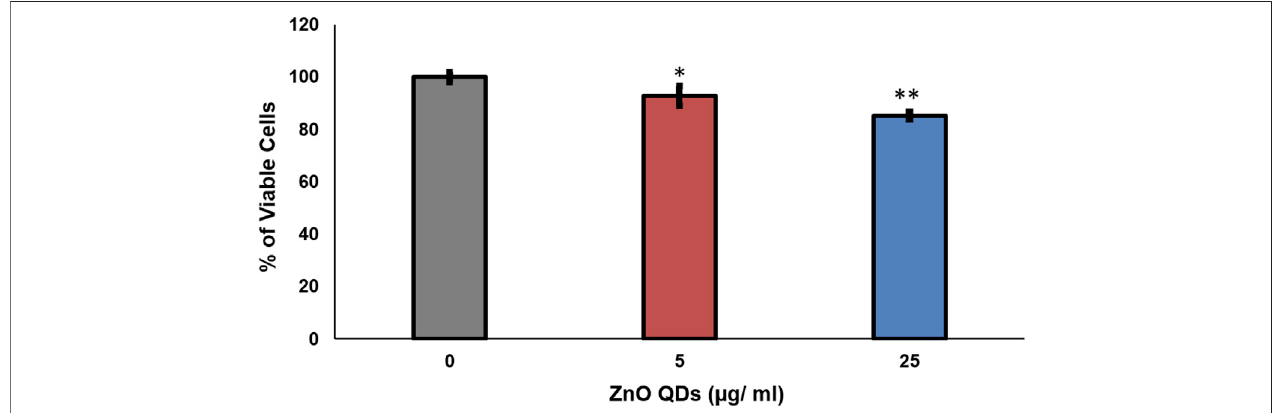
FIGURE6| Invitro cytotoxicactivityofZnOQDsagainstHeLacellline.Thevaluesaremean ± SDofthreeindependentsetsofexperiments.**represents p < 0.001, * represents p < 0.01, calculated with respect to growth control.